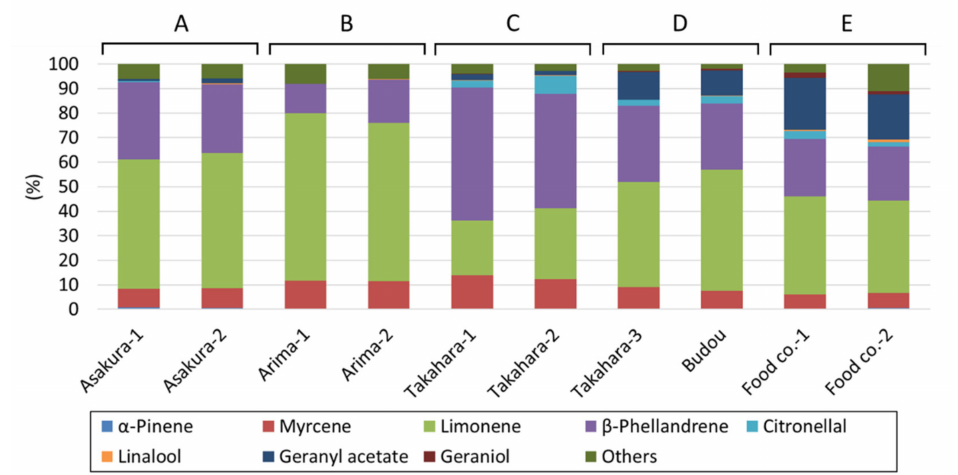
Figure 2. Volatile compounds of each Japanese pepper product. Data represent mean (peak area (%), n = 3 for each sample). “Food co.” means a product from a food company.